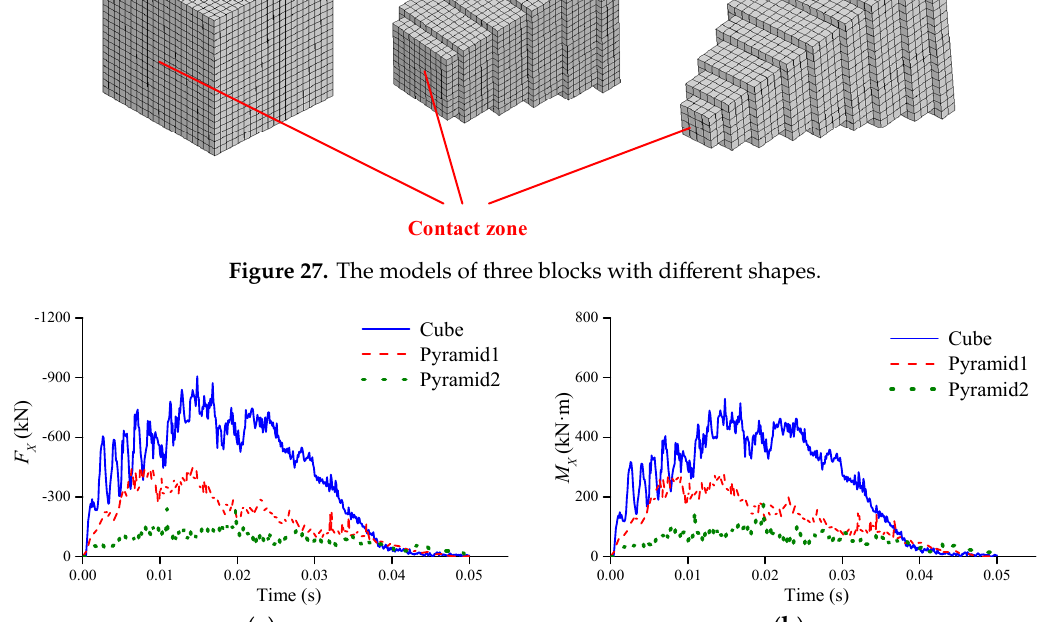
Figure 28. Time series of ice load Fx and Mx based on simulations with different ice blocks. ( a ) The Fx with different ice blocks. ( b ) The Mx with different ice blocks .